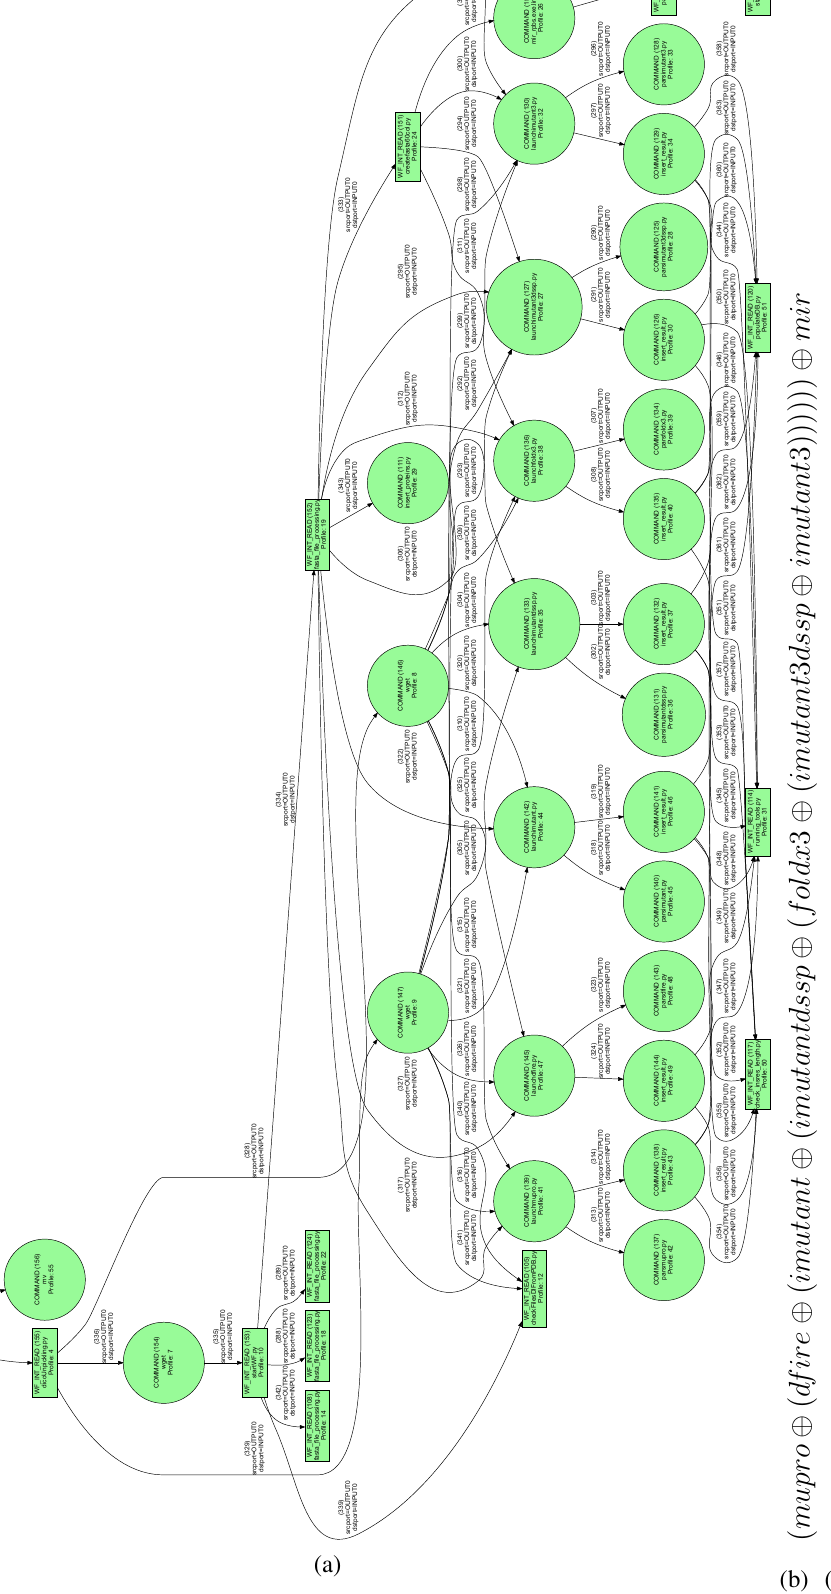
Figure 9: SPROUTS skeleton (a), implementation (b) and conceptual design